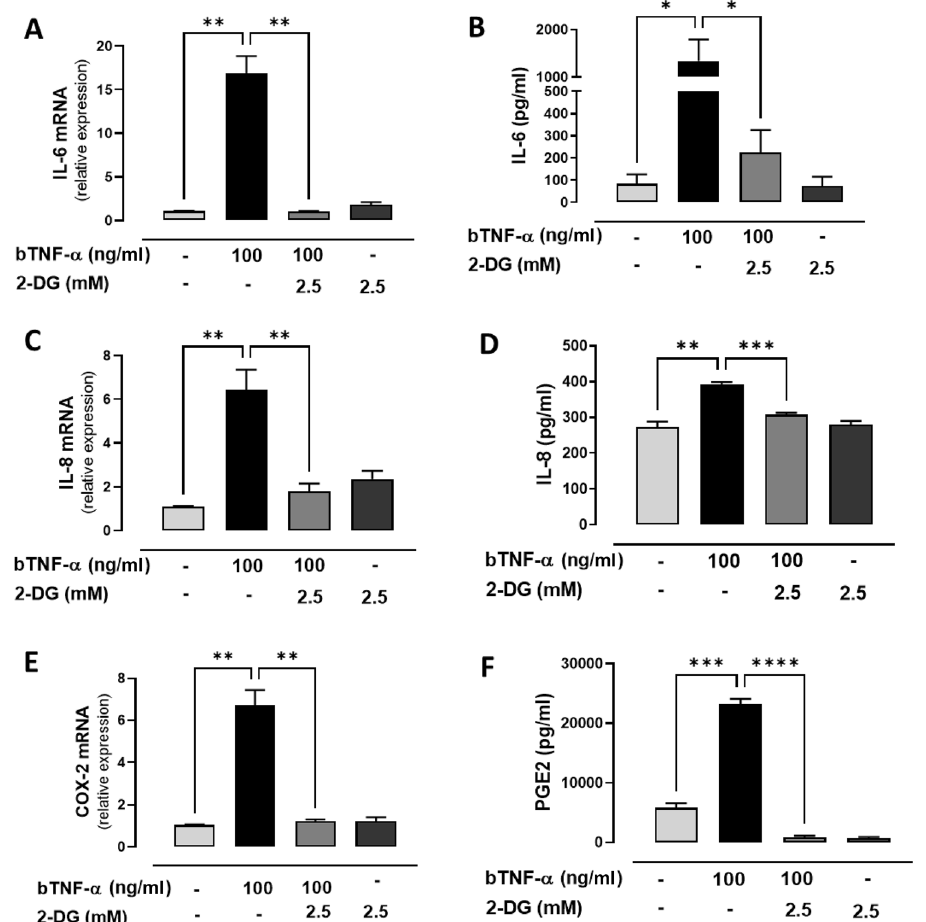
Figure 3. Participation of glycolysis in the expression of IL-6, IL-8 and COX-2/PGE2 in bFLS induced by bTNF-α. mRNA expression and production of IL-6 ( A , B ), IL-8 ( C , D ), and COX-2 ( E )/PGE2 ( F ) in bFLS treated or not with 2-DG and stimulated or not with bTNF-α. **** p < 0.0001; ***0.001; ** p < 0.01, and * p < 0.05 with respect to bTNF-α. Each bar represents the mean ± SEM, n = 4 independent